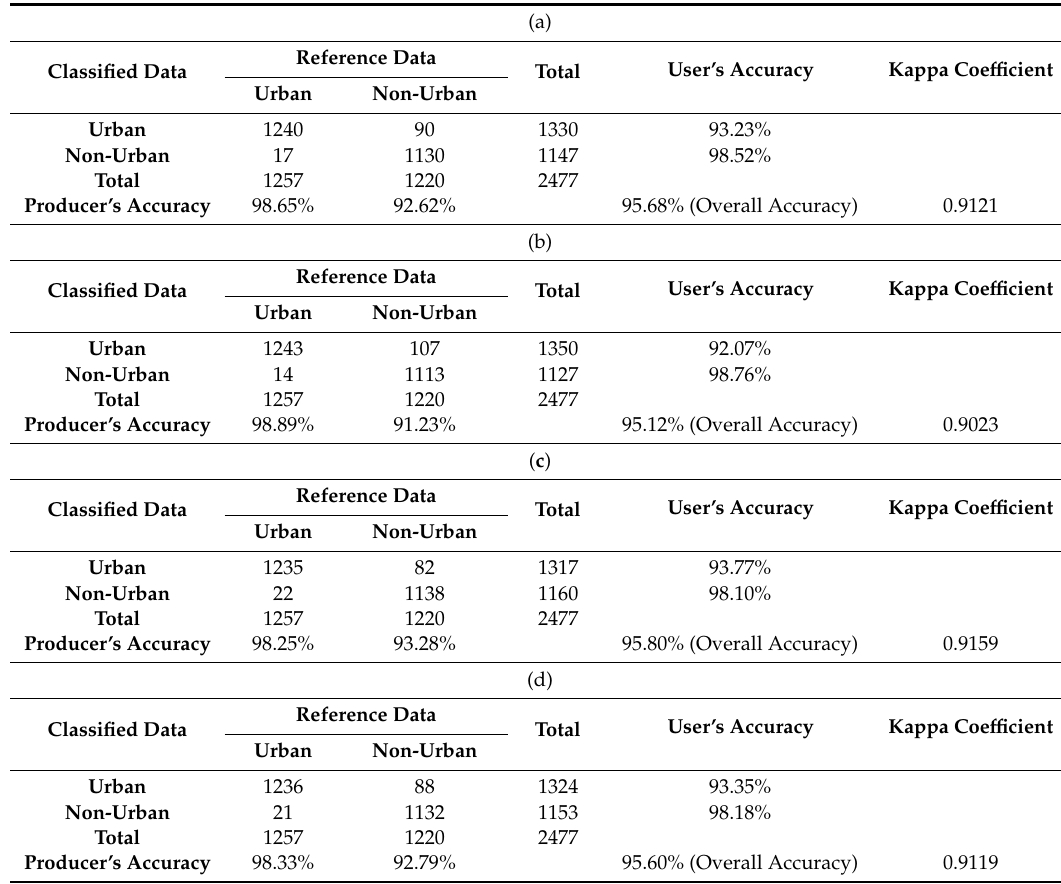
Table 2. Confusion matrices and accuracy assessment using “ground truth” reference samples: ( a ) randomforest(RF)-basedurbanextentaccuracyassessment, ( b )gradientboostingmachine(GBM)-based urban extent accuracy assessment, ( c ) neural network (NN)-based urban extent accuracy assessment, and ( d ) ESB-based urban extent accuracy